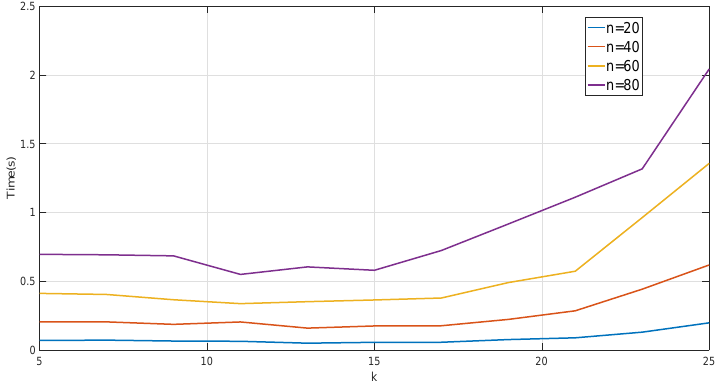
Figure 3. Calculation time with different diagonal numbers when the dimension n = 20,40,60,80.